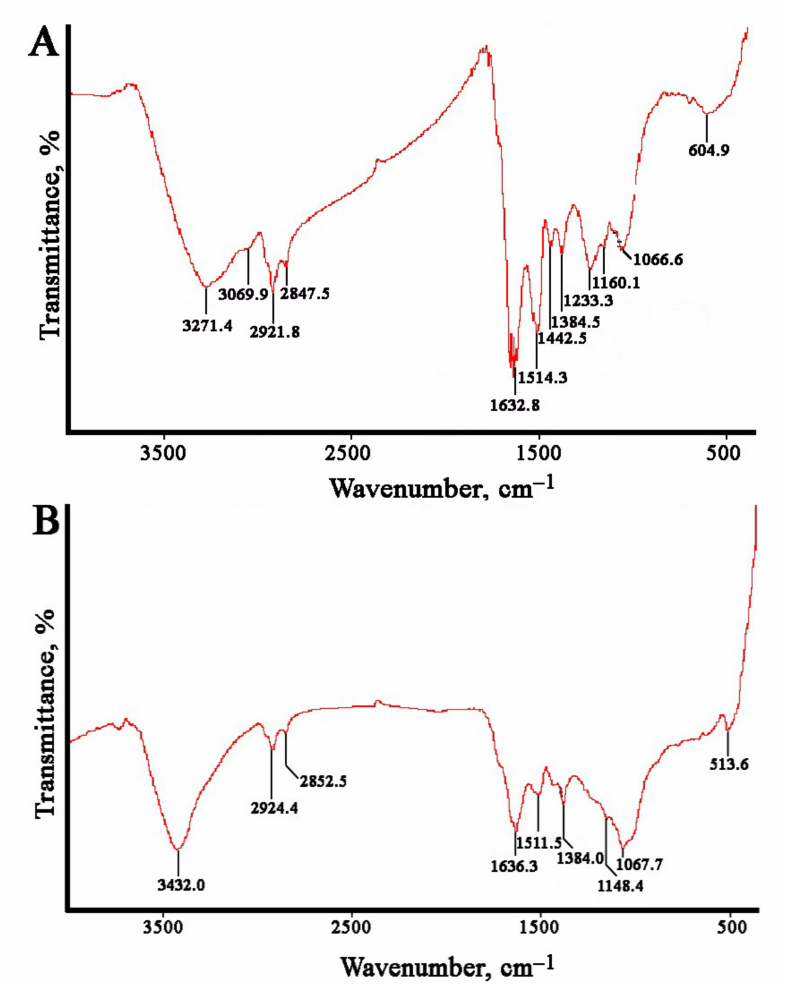
Figure 5. Fourier-transformed infrared (FTIR) spectroscopy analysis of AgNPs ( A ) and AuNPs ( B ) synthesized with L . erythrorhizon callus